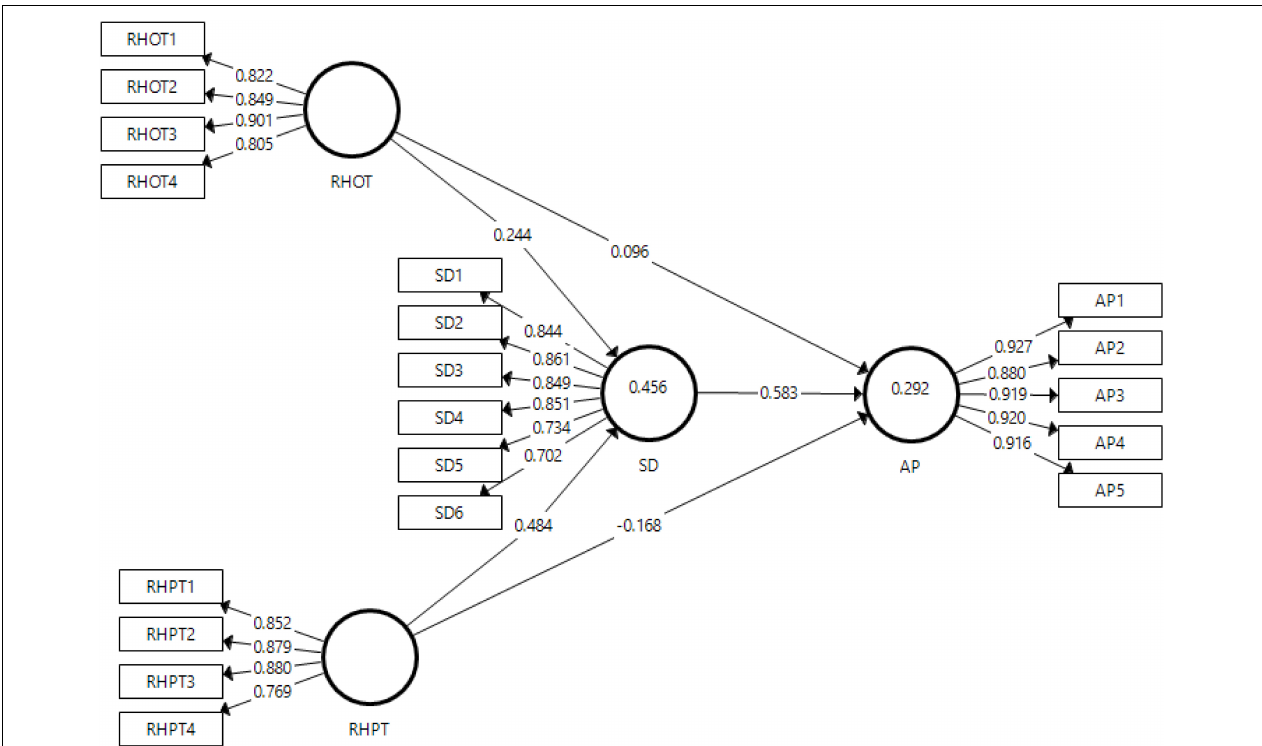
FIGURE 2 | The output of the measurement model. RHOT, rationalized knowledge hiding—online education; RHPT, rationalized knowledge hiding—physical education; SD, students’ disengagement; AP, students’ performance.